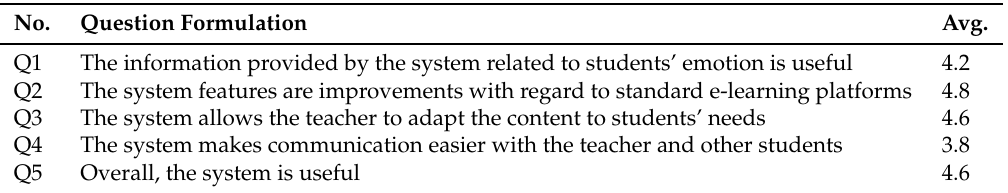
Table 6. Questionnaire for the